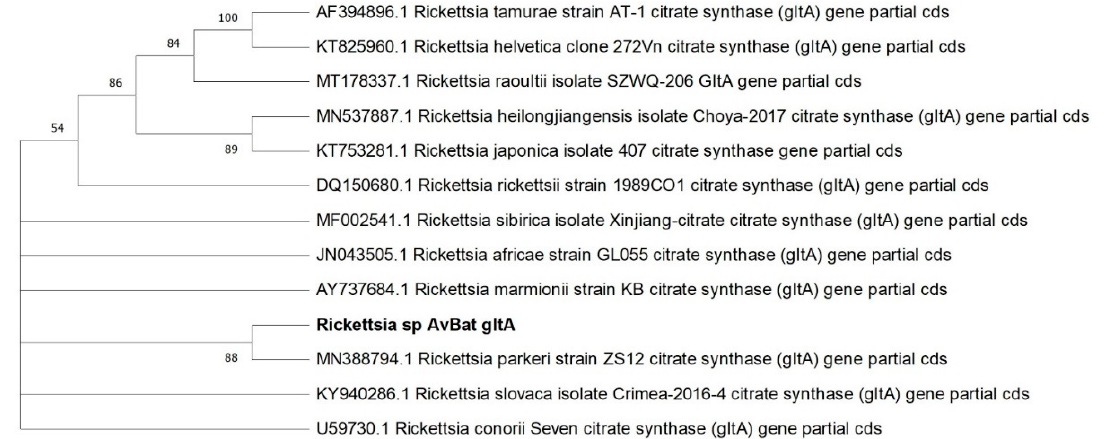
Figure 1. Phylogenetic tree based on gltA (I) gene sequences of Rickettsia species, constructed by maximum likelihood using Kimura 2-parameter and complete deletion. Sequences detected in our study (‘ Rickettsia sp. AvBat gltA ’, n = 43) are highlighted in bold. The reliability of the tree was tested by 500 bootstrap replicate analyses; only values greater than 50% are shown.